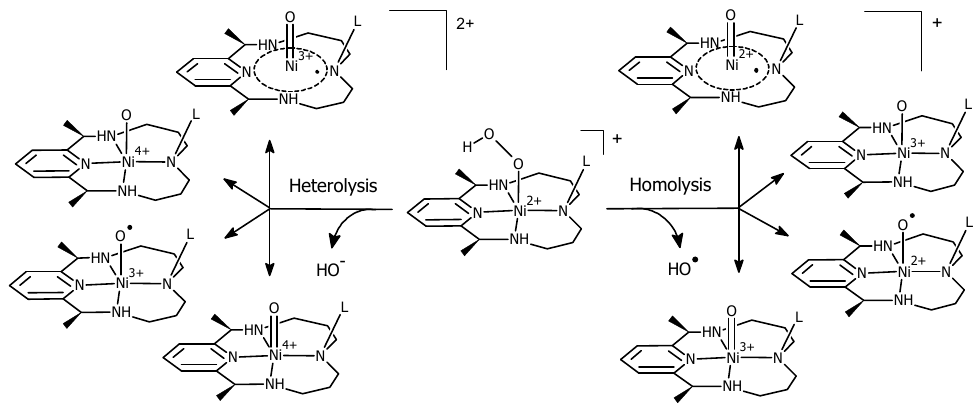
Scheme 5. Proposed reaction pathways (homolysis vs. heterolysis) for the O–O bond cleavage of nickel ‐ hydroperoxo intermediates. Table 5. Mulliken spin population of Ni and O axial in the three possible active nickel ‐ oxo intermediates calculated both in the gas phase and in solution. Values enclosed in brackets refer to solvated structures. Heterolytic cleavage of the O–O bond only led to high ‐ spin triplet intermediate. Catalyst